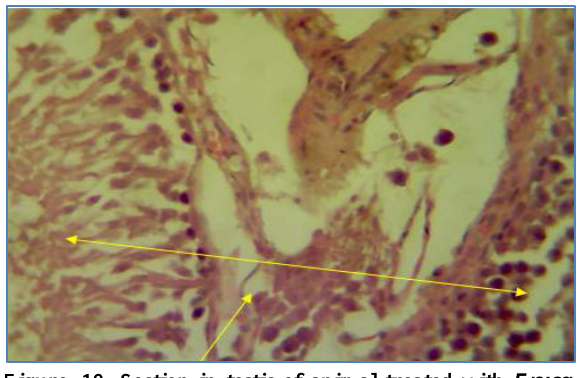
Figure, 19: Section in testis of animal treated with Eruca Sativa (G3) shows normal arrangement of seminiferous tubules with complete spermatogenesis ( ) and proliferation of Leydig cells ( ) (H and E stain